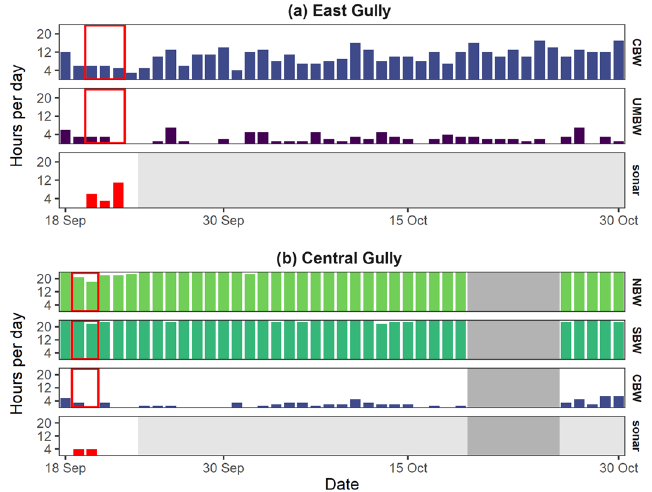
Figure 3. Number of hours per day with echolocation clicks from Cuvier’s beaked whales (CBW), unidentified Mesoplodont beaked whales (UMBW), northern bottlenose whales (NBW), Sowerby’s beaked whales (SBW), and sonar at the ( a ) East Gully and ( b ) Central Gully recording sites. Dark grey shading indicates periods of missing data; light grey shading on the sonar plots indicates periods not analyzed for the presence of sonar signals. The solid red box delineates the period with sonar signals present at each recording site.